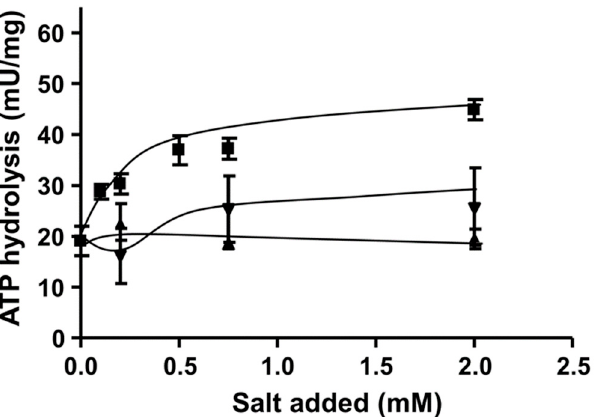
Figure 5. Sodium ion dependence of ATP hydrolysis activity in C. aceticum . 135 µg of purified membranes were added to 1200 µL ATPase buffer (100 mM Tris-HCl, 100 mM malic acid, pH 7.4) containing NaCl ( ■ ), KCl ( ▲ ) or LiCl ( ▼ ). The sample was incubated for 3 minutes at 30 °C. The reaction was started by adding 3 mM Tris-ATP. The contaminating Na + concentration was 10 µM. Results show data from two replicates.